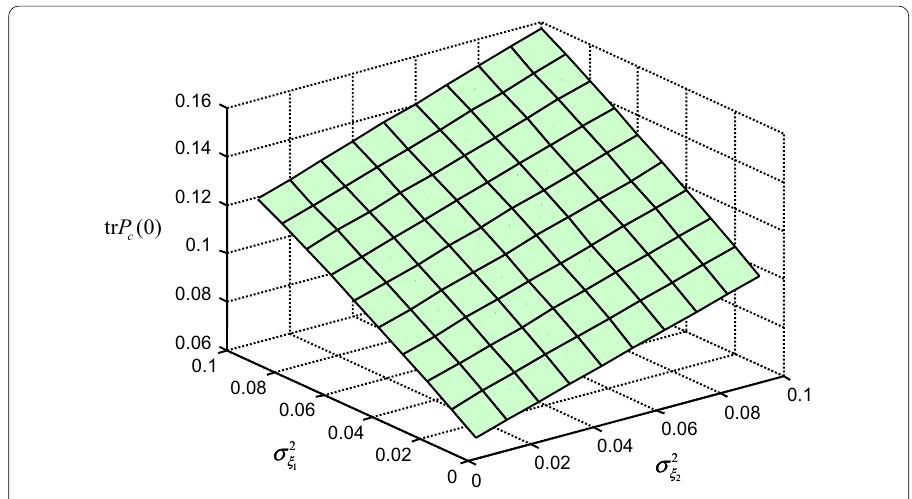
Fig. 3 Changes of tr P c ( 0 ) with respect to σ 2 ξ